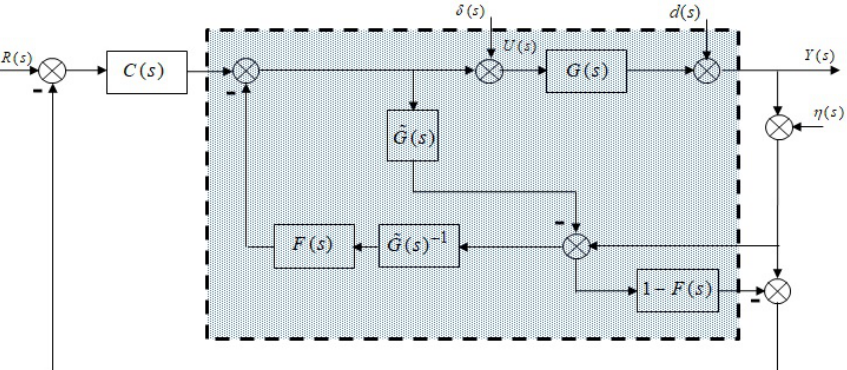
Figure 6. Noise reduction disturbance observer control